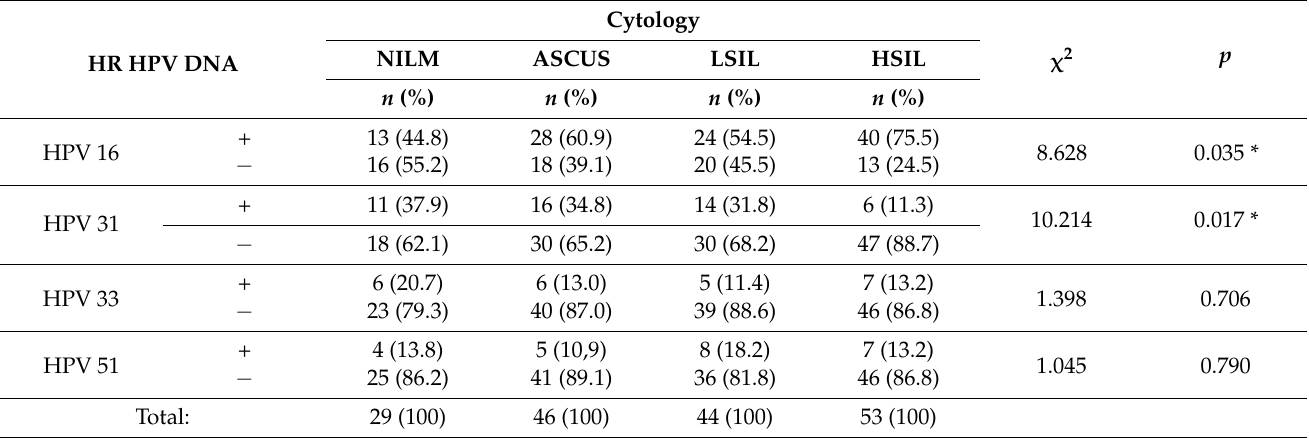
Table 4. Distribution of the most frequently detected HR HPVs according to cytology.